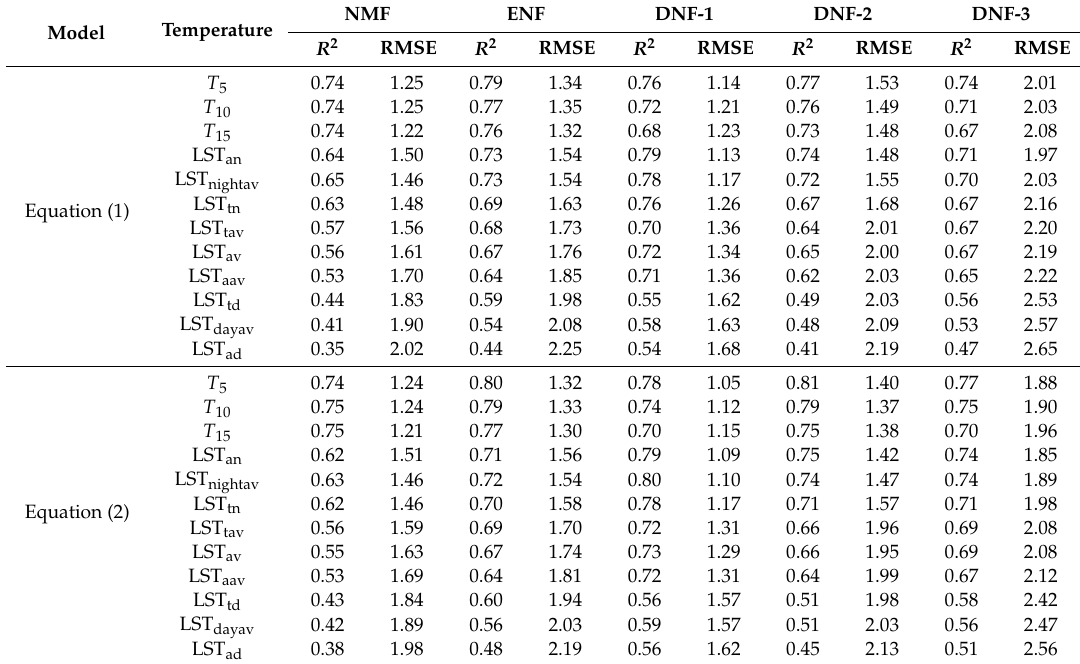
Table 5. Results of the statistical analysis of the fitted Equations (1) and (2) relating soil respiration to temperatures on the five sites for all measured data during the